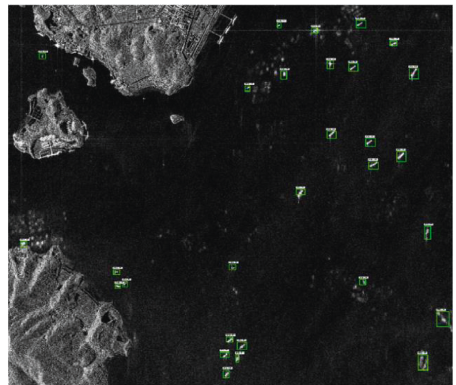
Figure 21: Land-sea segmentation result and confidence value of test box.